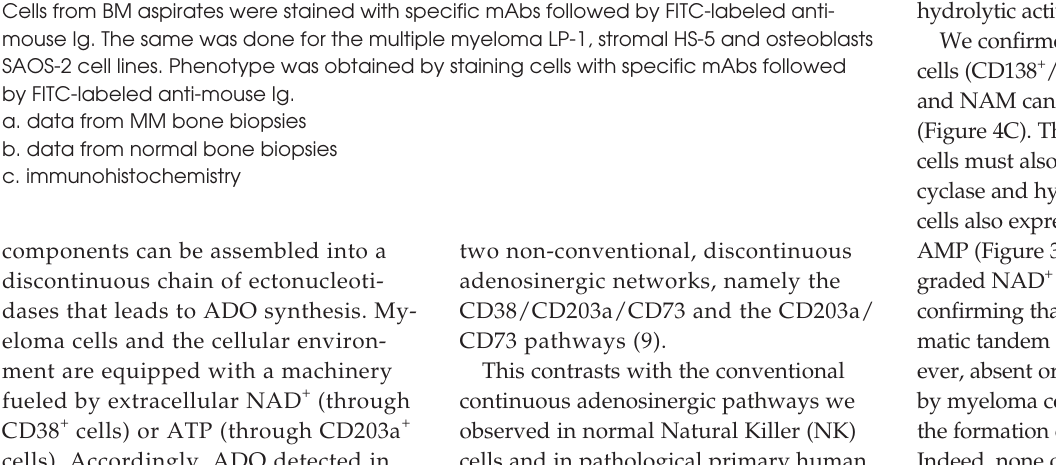
mouse Ig. The same was done for the multiple myeloma LP-1, stromal HS-5 and osteoblasts SAOS-2 cell lines. Phenotype was obtained by staining cells with specific mAbs